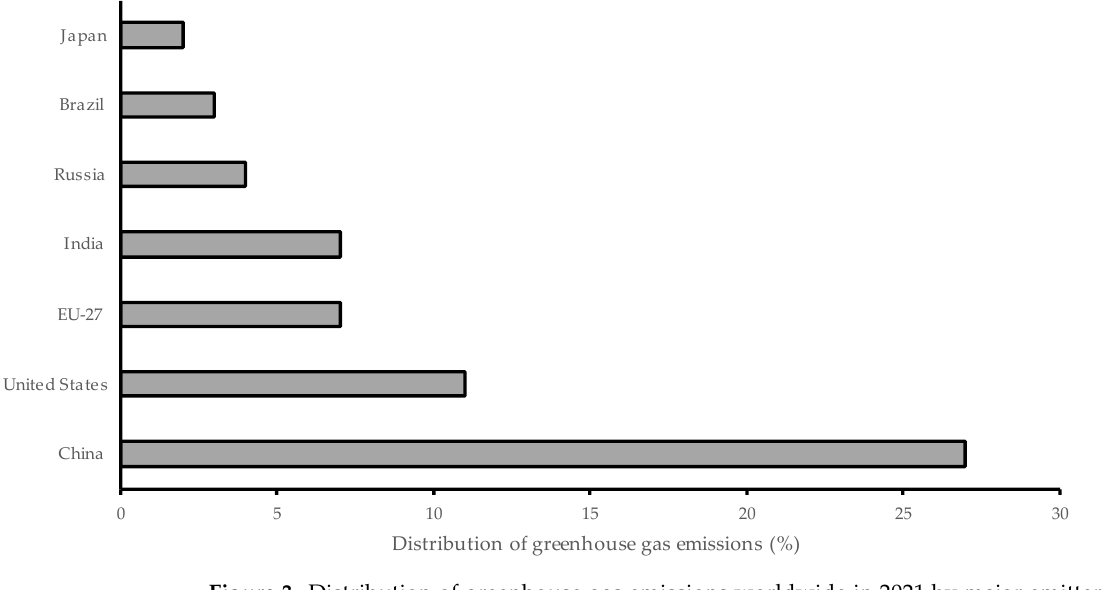
Figure 3. Distribution of greenhouse gas emissions worldwide in 2021 by major emitter adapted from https://www.statista.com/, accessed on 15 March 2023).